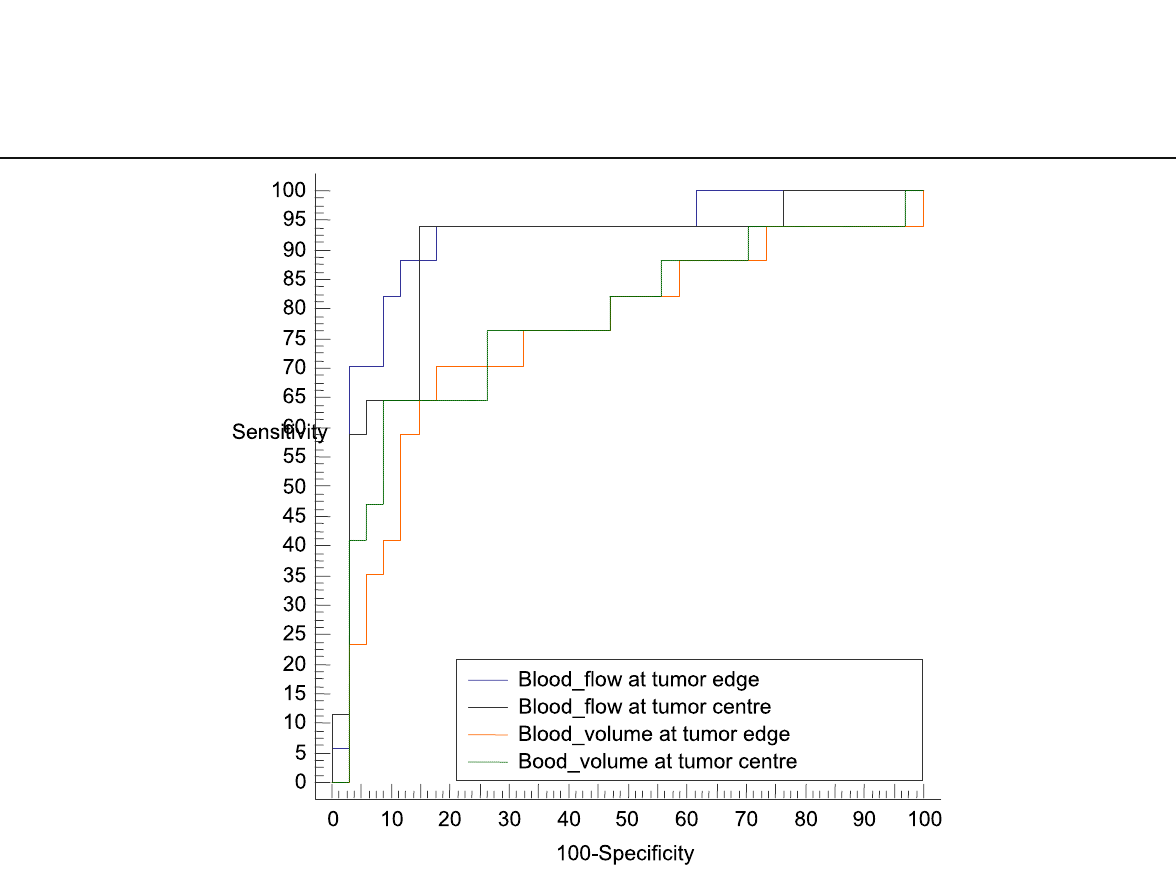
Fig. 4 Diagnostic performance of blood flow and volume in diagnosing poorly differentiated